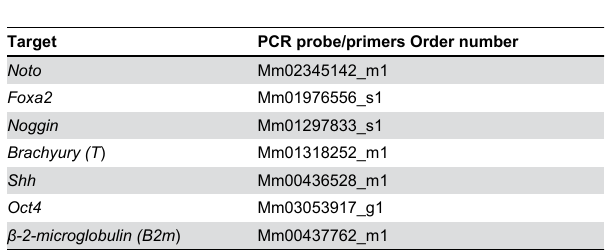
Table 2. Probes and primers of notochordal-cell markers analyzed by real-time RT-PCR (Applied